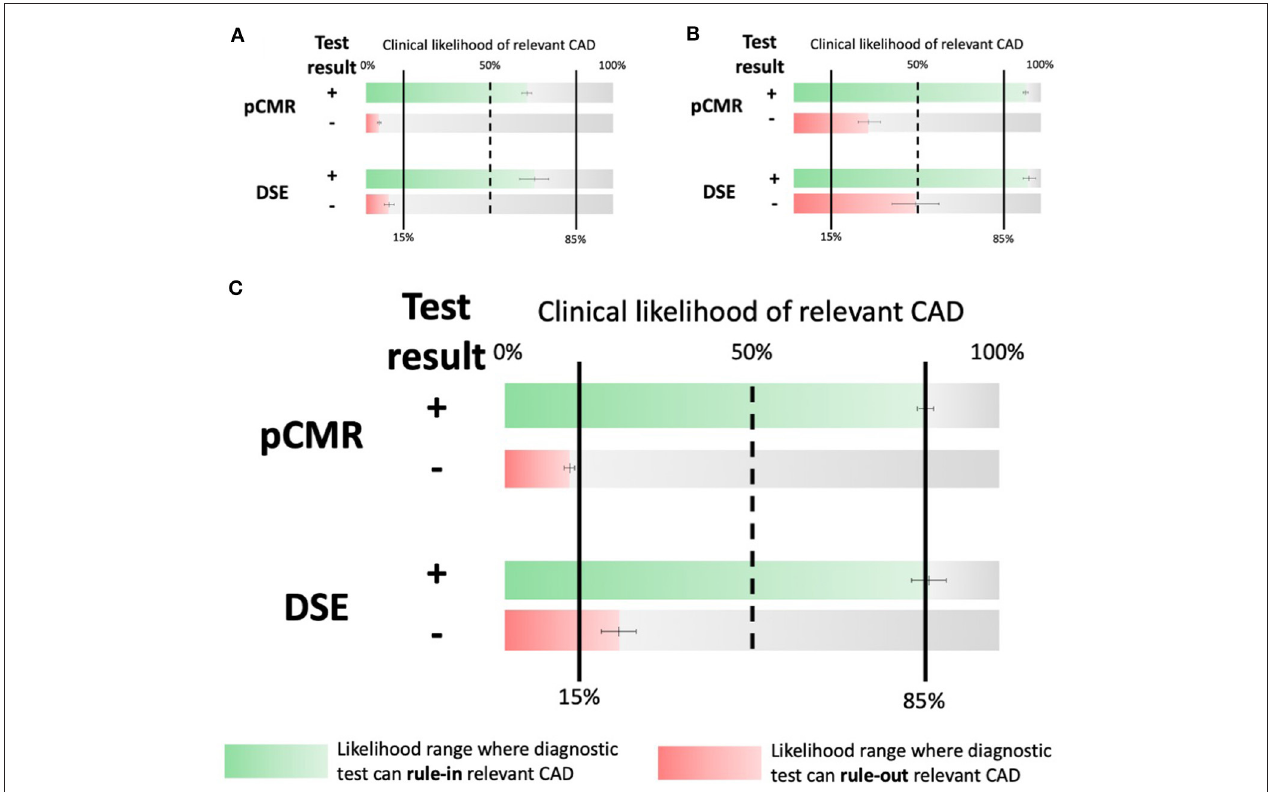
FIGURE 4 | Central Illustration. Likelihood ranges at which the respective tests can rule-in (green) and rule-out (red) obstructive CAD. (A) Respective likelihood ranges at a low (25% PrTP). (B) a high risk (75% PrTP) of obstructive CAD and (C) Respective likelihood ranges at an intermediate risk of CAD (50% PrTP). Note that only pCMR can rule-out relevant CAD (defined as PoTP < 15%) at an intermediate PrTP. CAD, coronary artery disease; PrTP, pre-test probability; PoTP,